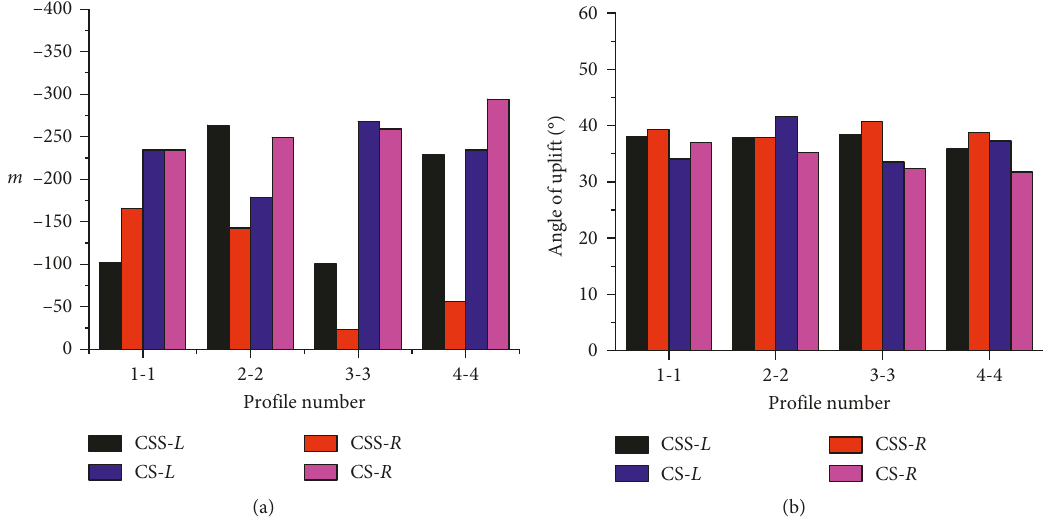
Figure 12: Fitting data for failure planes. (a) Data of m. (b) Data of θ